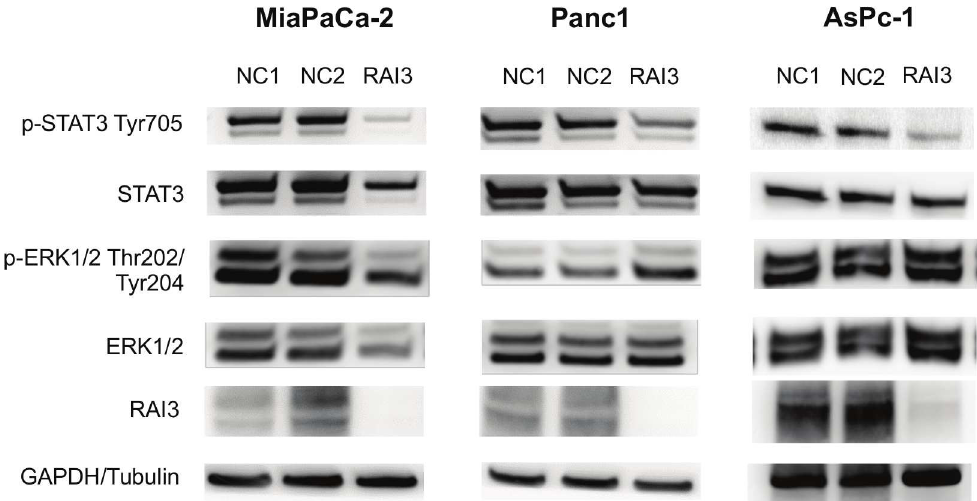
Fig 6. Western Blot analysis of different pathways were tested for alteration in knock-down with GPRC5A siRNA in comparison to negative control. Phosphorylation of STAT3 at Tyr705 is reducedin knock-downof all three cell lines, whereasPhospho-ERK is not changedsignificantly (see S2 Fig for originalWestern blot images). (n = 3).